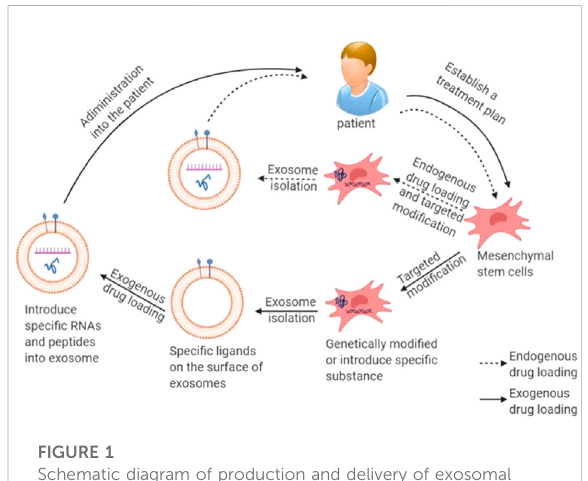
FIGURE 1 Schematic diagram of production and delivery of exosomal drug:mesenchymalstemcellsareobtainedfromthepatient ’ sown body to produce exosomes, and then endogenous or exogenous drug is loaded, and fi nally injected into the